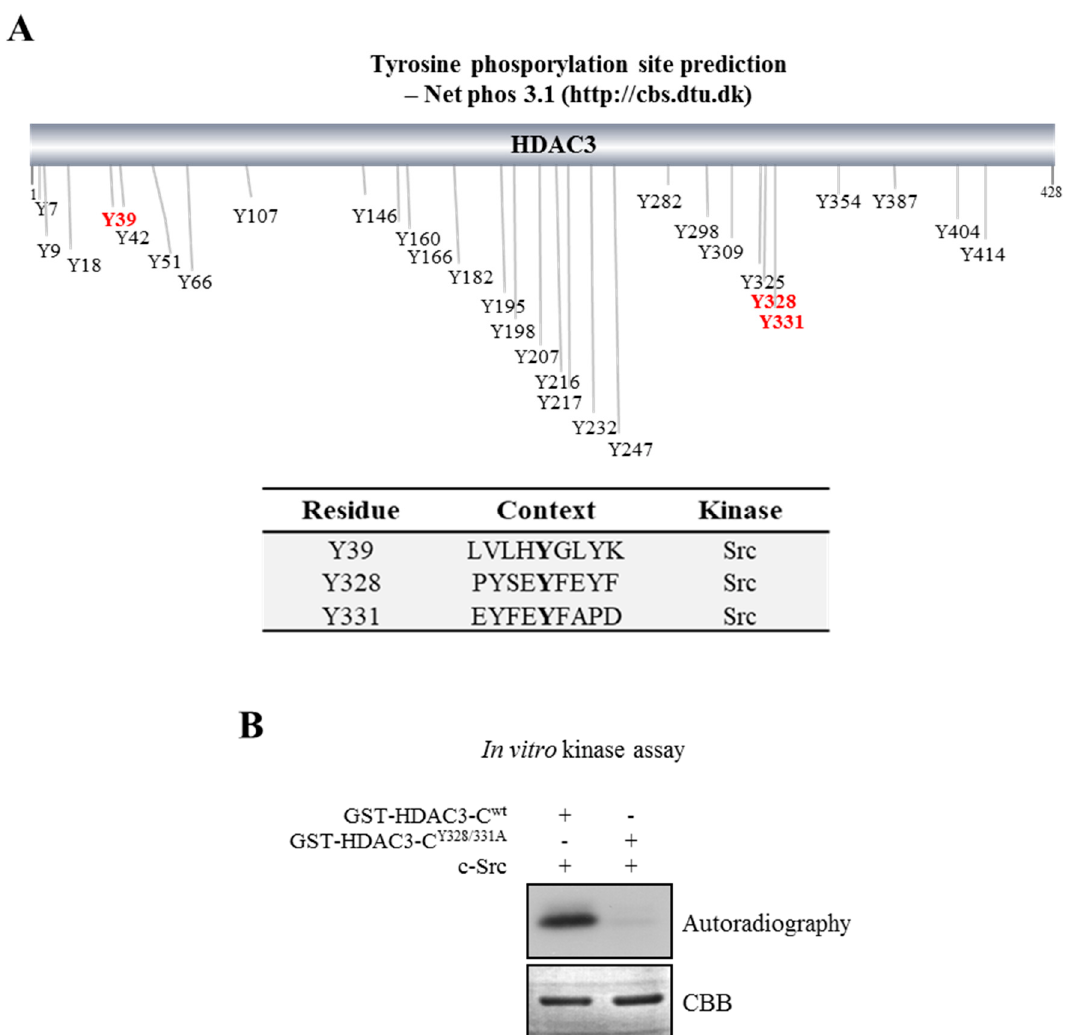
Figure 1. In vitro phosphorylation of Y328 and Y331 on histone deacetylase 3 (HDAC3). ( A ) Prediction of putative phosphorylation sites at tyrosine residues on HDAC3. Putative tyrosine phosphorylation residues on HDAC3 were predicted using an artificial neural network predictor of phosphorylation sites, the Net Phos3.1 (http://cbs.dtu.dk) program. The proto-oncogene tyrosine-protein kinase (c-Src)-mediated putative phosphorylation residues are highlighted in red. ( B ) HDAC3 is phosphorylated by c-Src. In vitro kinase assays were performed with recombinant c-Src and the indicated glutathione (GST)-fused HDAC3 proteins. The samples were processed for SDS-PAGE and subsequently visualized by autoradiography. CBB, Coomassie blue staining.